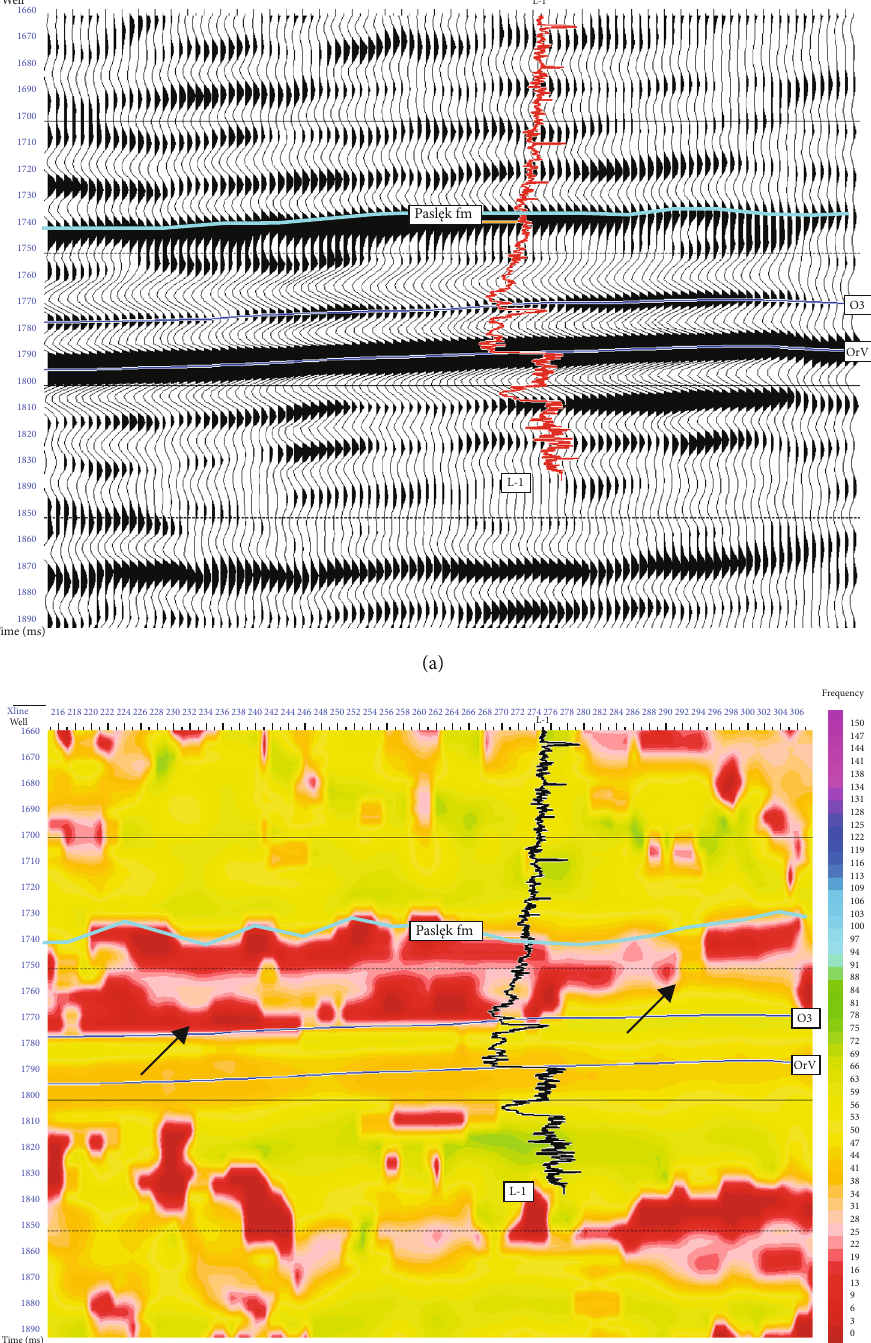
Figure 10: Zoomed seismic pro fi le that goes through the well: (a) migrated seismic section, (b) spectral decomposition based on the FFT algorithm. The curve is P wave velocity. In (b), red colours indicate lower frequencies, and purple indicates higher frequencies. Horizons ’ marks are O3: the top of the Prabuty formation and Orv: top of the Kopalino formation. Arrows indicate the characteristics of the low frequency anomaly (described in